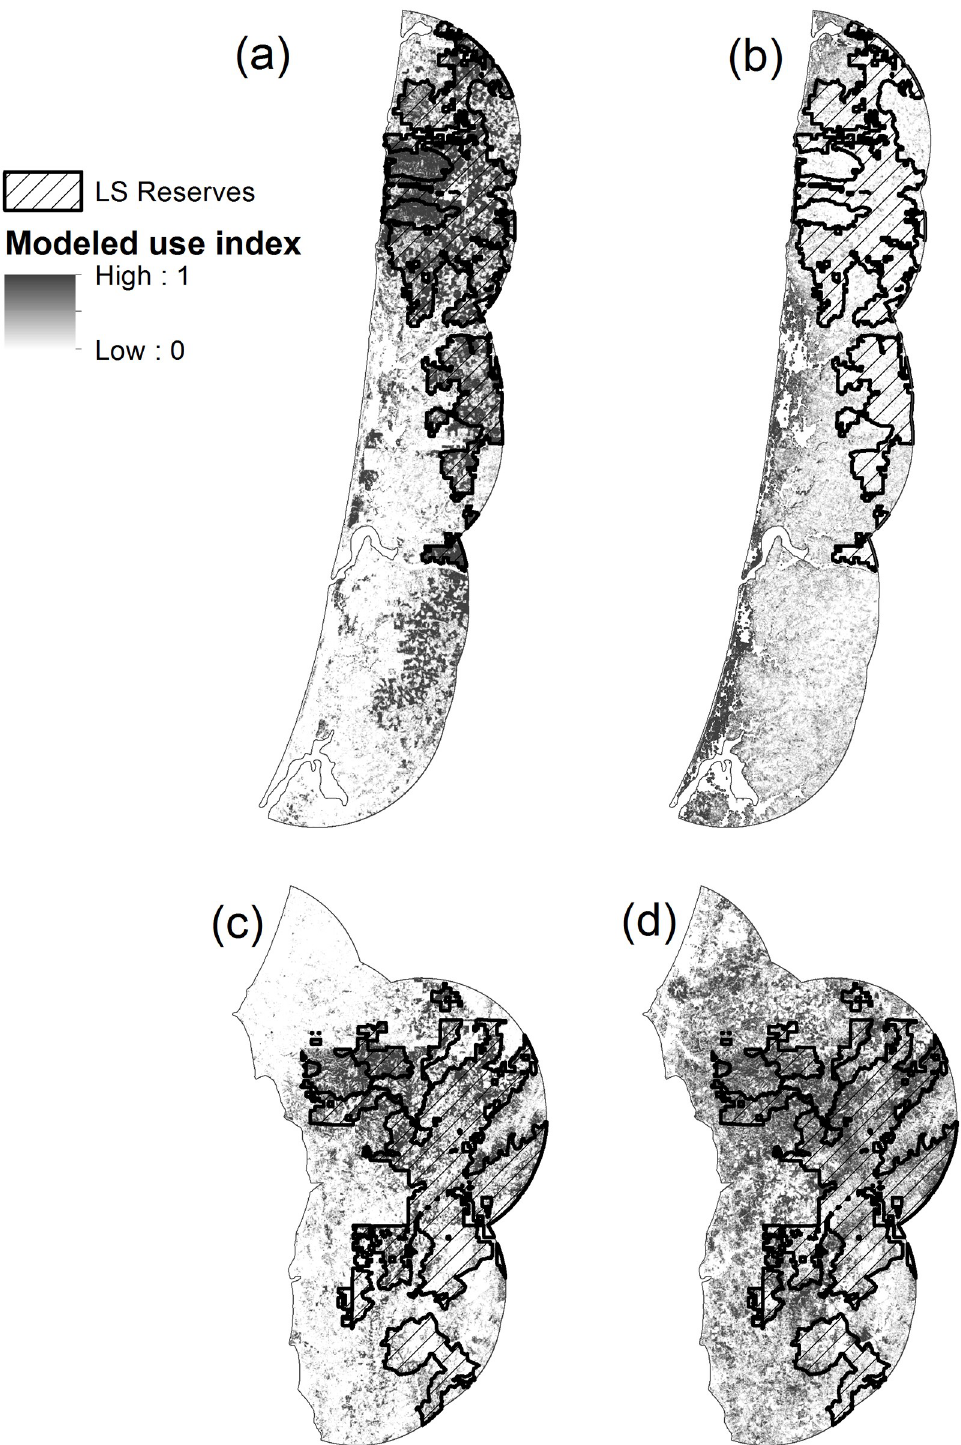
Fig 8. Humboldt marten and spotted owl distribution models. Species distribution models based on observed species use vs. available for use. Top maps show relative likelihood of use for northern spotted owls (a) and a coastal subspecies of Pacific martens (b) in the Central Coast. Bottoms maps show relative likelihood of use for northern spotted owls (c) and Humboldt marten (d) in the South Coast. Cross-hatched areas were designated as late-successional forest reserves under the 1994 Northwest Forest Plan.